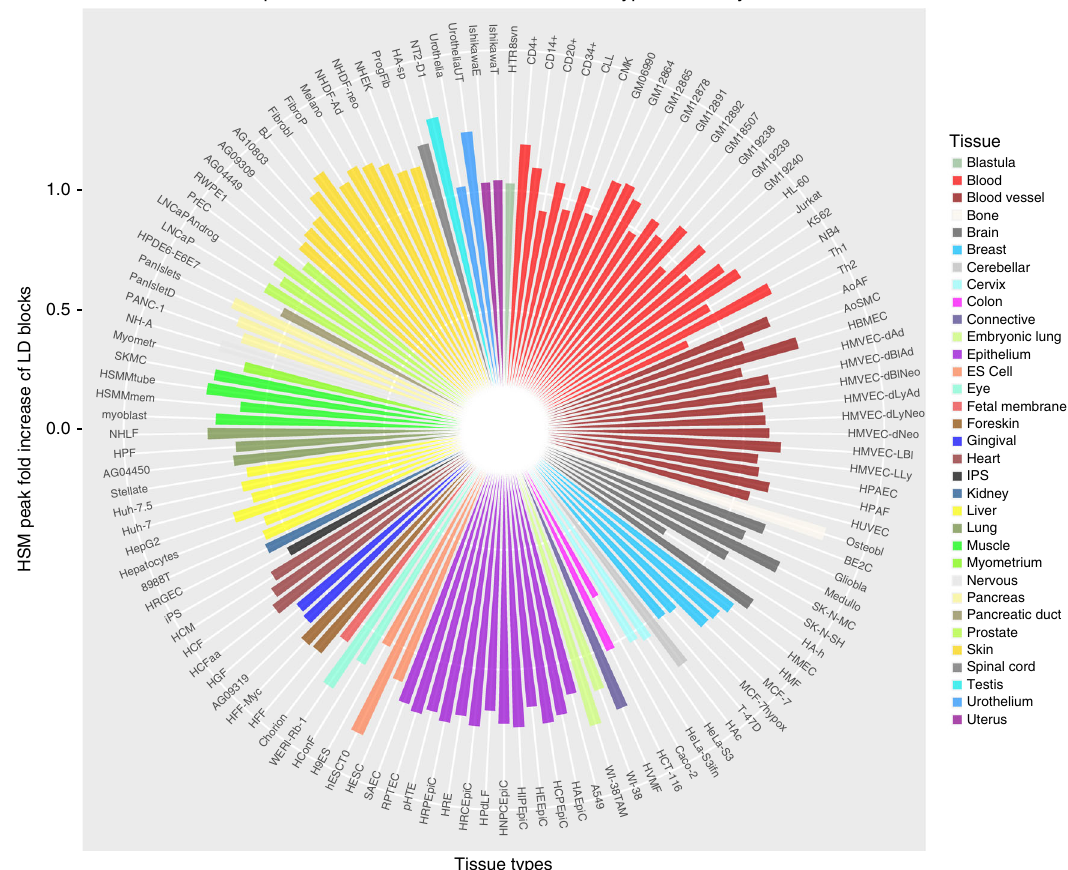
Fig. 8 Tissue-speci fi c DNase-I hypersensitivity site enrichment. Fold enrichment for overlap of HSM peaks with 125 tissue-speci fi c DNase-I hypersensitivity site data (via ENCODE) compared to the genome. Y -axis indicates log 2 fold